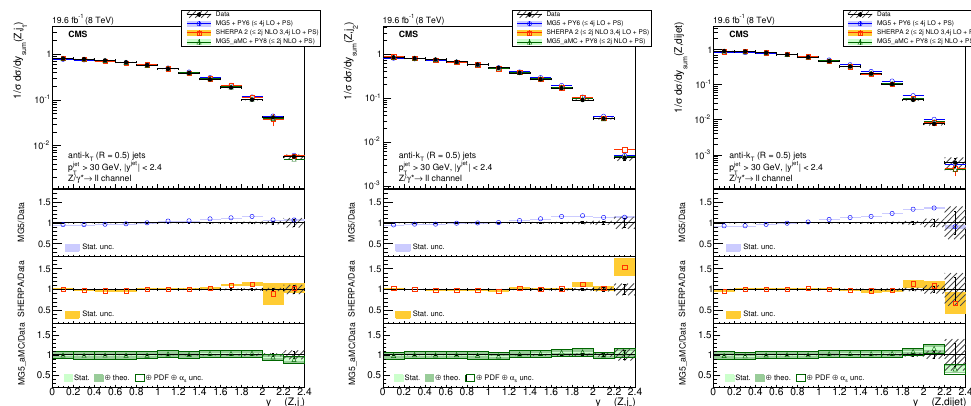
Figure 14 . The normalised di(cid:11)erential cross section for Z ( ! ‘‘ )+jets ( N jets (cid:21) 2) production mea- sured as a function of the y sum of the Z boson and (left) the leading jet, (middle) the second-leading jet, and (right) the system constituted by these two jets. The measurement is compared to the predictions calculated with MadGraph 5 + pythia 6, sherpa 2, and mg5 a mc + pythia 8. The lower panels show the ratios of the theoretical predictions to the measurements. Error bars around the experimental points show the statistical uncertainty, while the cross-hatched bands indicate the statistical and systematic uncertainties added in quadrature. The boxes around the mg5 a mc + pythia 8 to measurement ratio represent the uncertainty on the prediction, including statistical, theoretical (from scale variations), and PDF uncertainties. The dark green area represents the statistical and theoretical uncertainties only, while the light green area represents the statistical uncertainty alone.